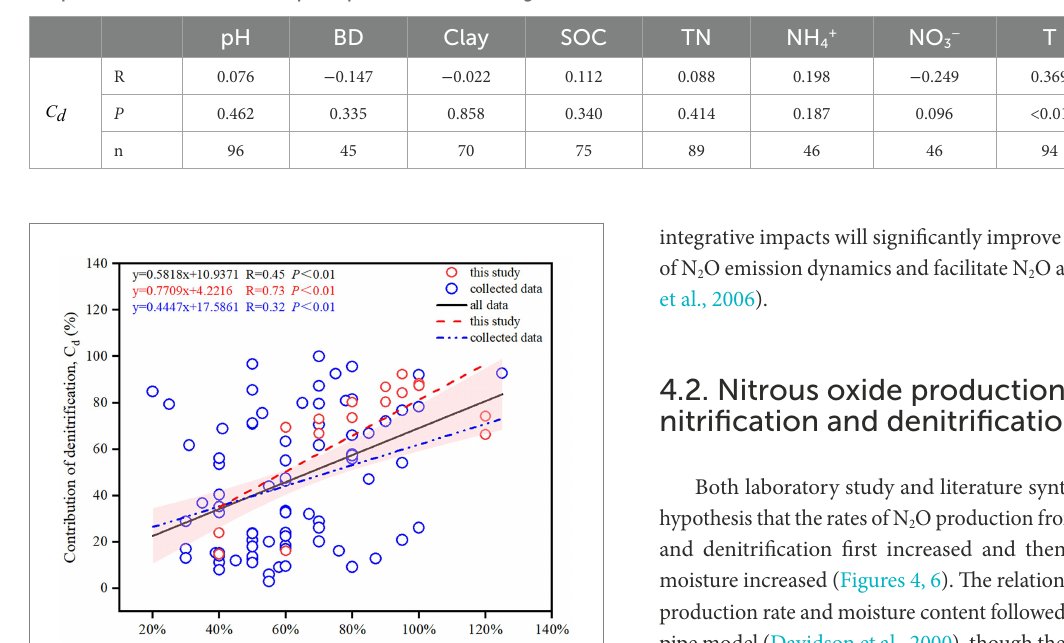
TABLE 1 Correlations between the contribution of denitrification ( C d ) and soil properties as well as environmental conditions, which include soil pH, bulk density (BD), clay content, soil organic carbon (SOC), total nitrogen (TN) concentrations, NH 4+ and NO 3− concentrations, incubation temperature (T) and water-filled pore space (WFPS), across agricultural soils.